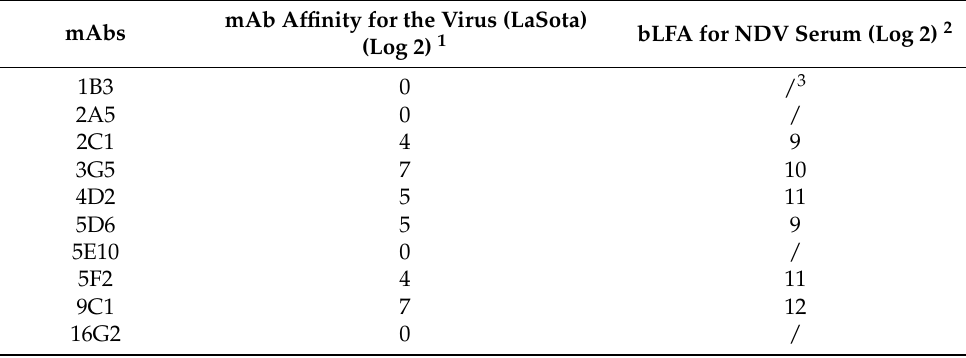
Table 1. Screening of Monoclonal antibodies against HN protein for the bLFA. mAb Affinity for the Virus (LaSota) mAbs (Log 2) 1